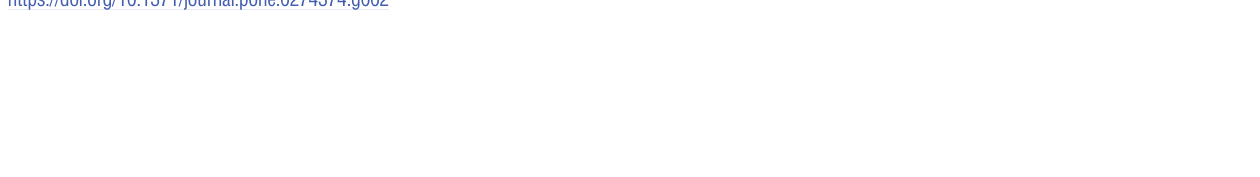
PLOS ONE | https://doi.org/10.1371/journal.pone.0274374 September 28,